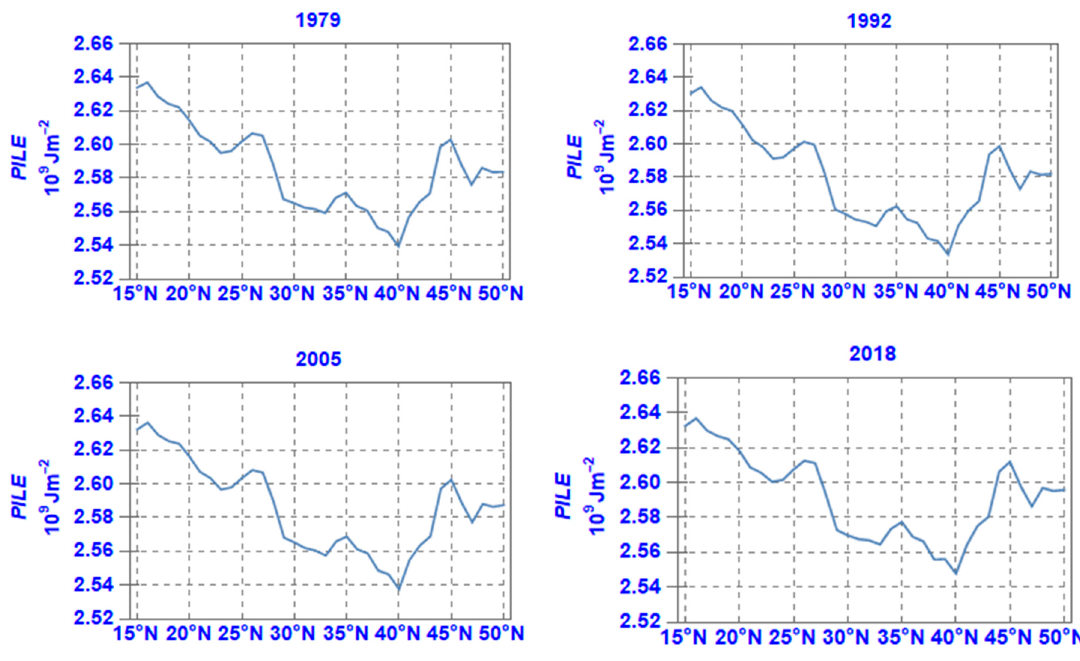
Figure 12. Same as Figure 3 but for PILE .